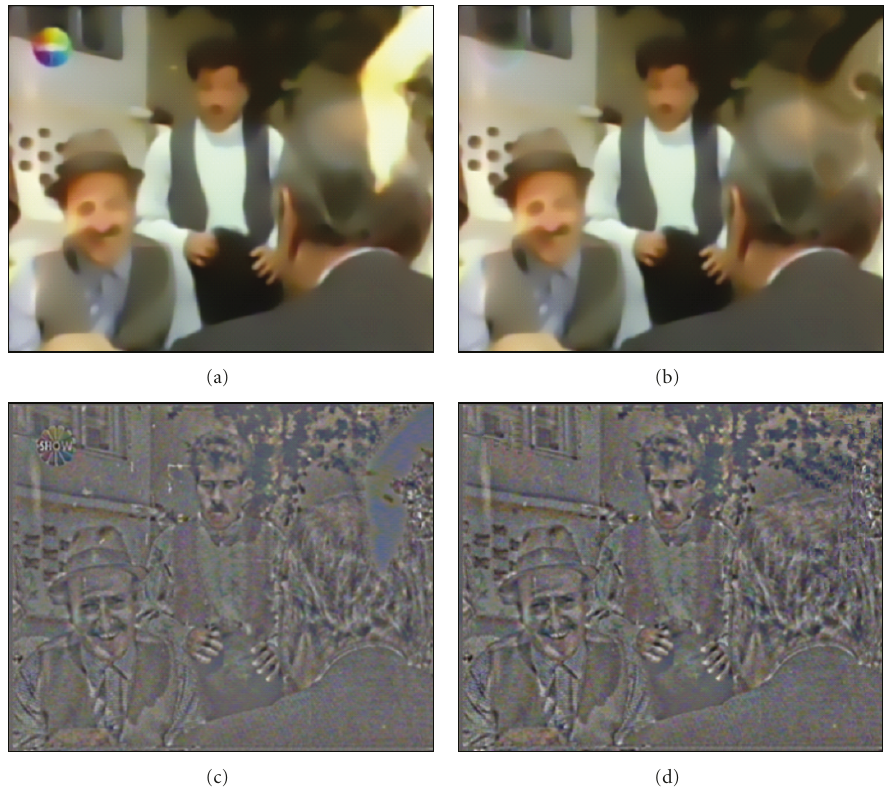
Figure 18: Geometry (a) and texture (c) components are generated by the proposed method, and the reconstructed geometry image (b) and the completed texture image (d) are obtained by the proposed